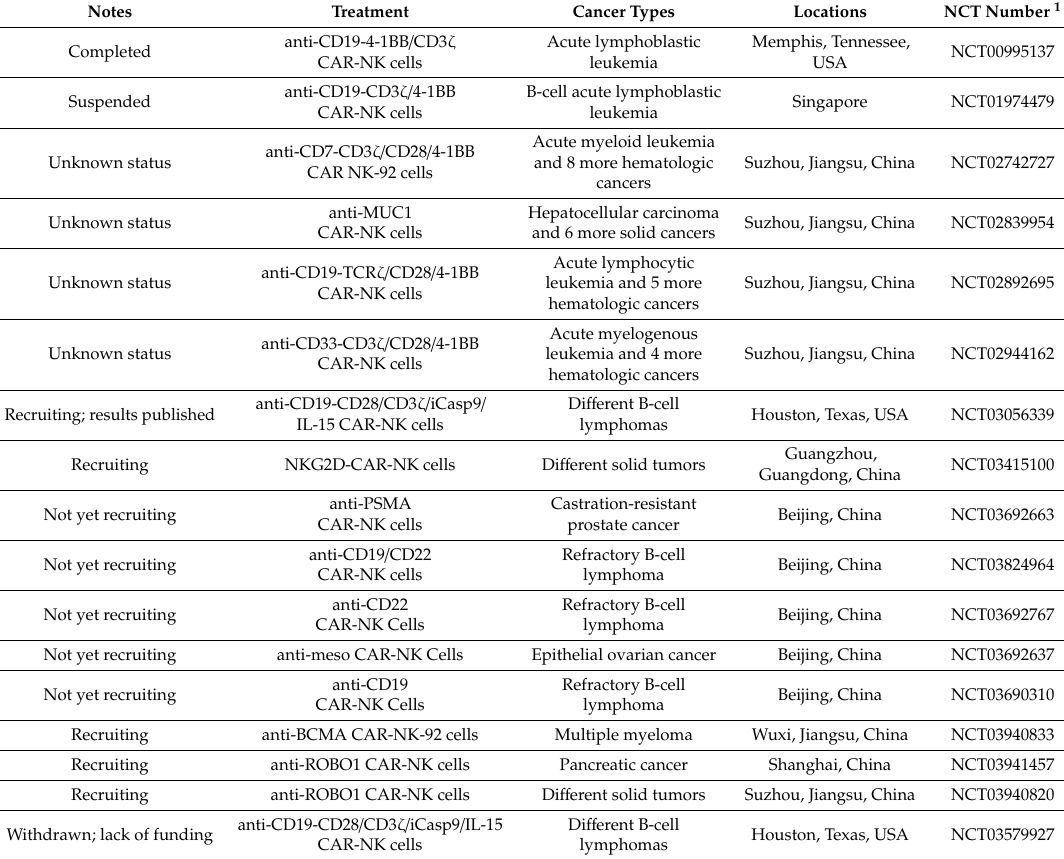
Table 2. List of clinical trials employing CAR-NK cells listed on